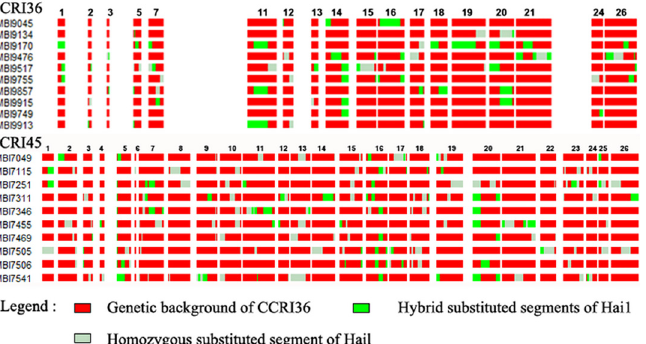
Fig 2. Graphical genotypes of the chromosome segment substitution lines